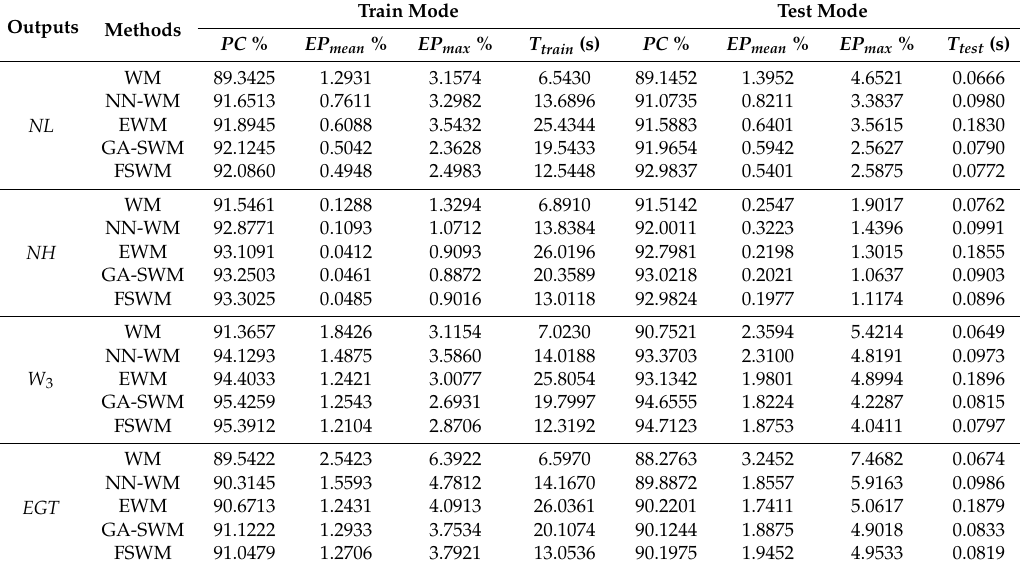
Figure 5. The time constant variation of linear dynamic block in the FSWM: ( a ) NL ; ( b ) NH ; ( c ) W 3 ; ( d ) EGT .